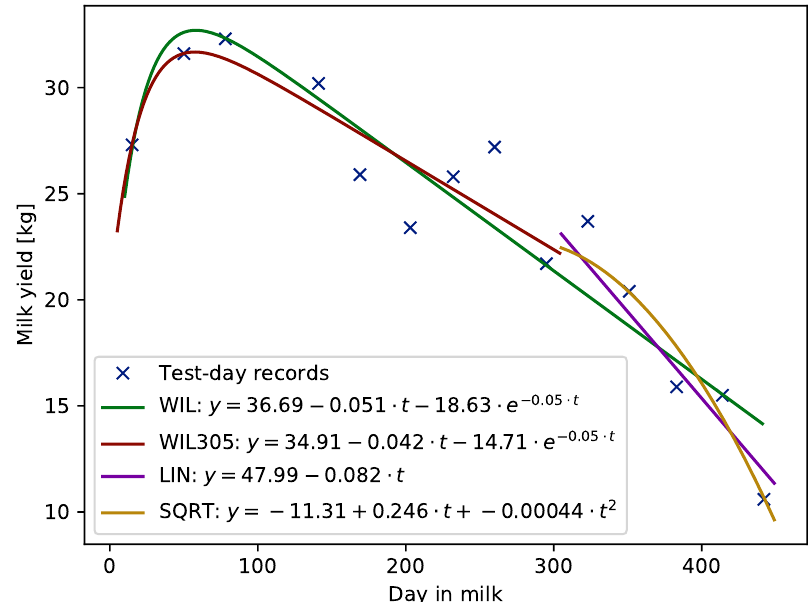
Figure 1. Example of lactation curve with standard shape fitted using Wilmink (WIL and WIL305), linear (LIN) and squared (SQRT) functions. Table 3. Goodness of fit of WIL and WIL305 functions to test-day (TD) records until 305 day in milk No. of